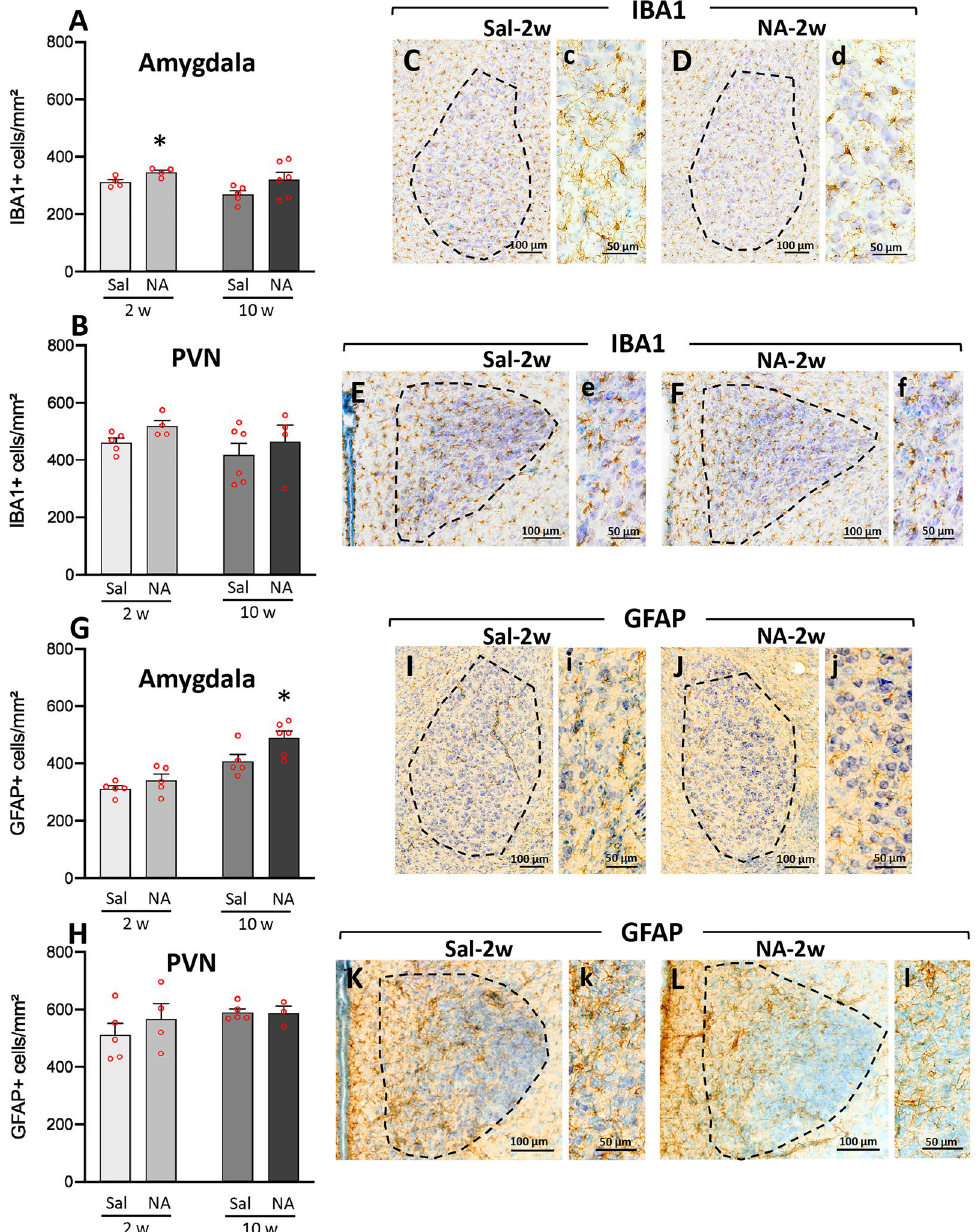
Figure 7. IBA1-positive and GFAP-positive cell counts in amygdala and hypothalamic PVN after neuraminidase induced neuroinflammation. Rats ICV-injected with saline (Sal) or with neuraminidase (NA) were sacrificed 2 weeks (2w) or 10 weeks (10w) after the ICV. Their brains were removed and processed for immunostaining with IBA1 (a widely used marker of microglial cells) or GFAP (a marker of astrocytes). Positive cells are labeled in brown; sections were counterstained with toluidine blue. IBA1-positive cell counts were carried out in two regions related to anxiety and to the stress response: the amygdala ( A ) and the hypothalamic paraventricular nucleus (PVN; B ). In the same way, GFAP-positive cell counts were performed in the amygdala ( G ) and the PVN ( H ). The bars in histograms represent the mean ± SEM of n = 5–6 animals per experimental group. Student’s t-test were performed in order to check the influence of treatment (Sal versus NA) at both time assessments on the number IBA1-positive or GFAP-positive cells (* p < 0.05). Representative images of IBA-1 labeled amygdala ( C , D ) and PVN ( E , F ) are shown, as well as GFAP labeled amygdala ( I , J ) and PVN ( K , L ), all from animals sacrificed 2 weeks after the injection; the area of interest where the cell count was performed is delimited with a broken line. Images c – f (on the right of C – F ) and i – l (on the right of I – L ) are a magnified detail of each respective